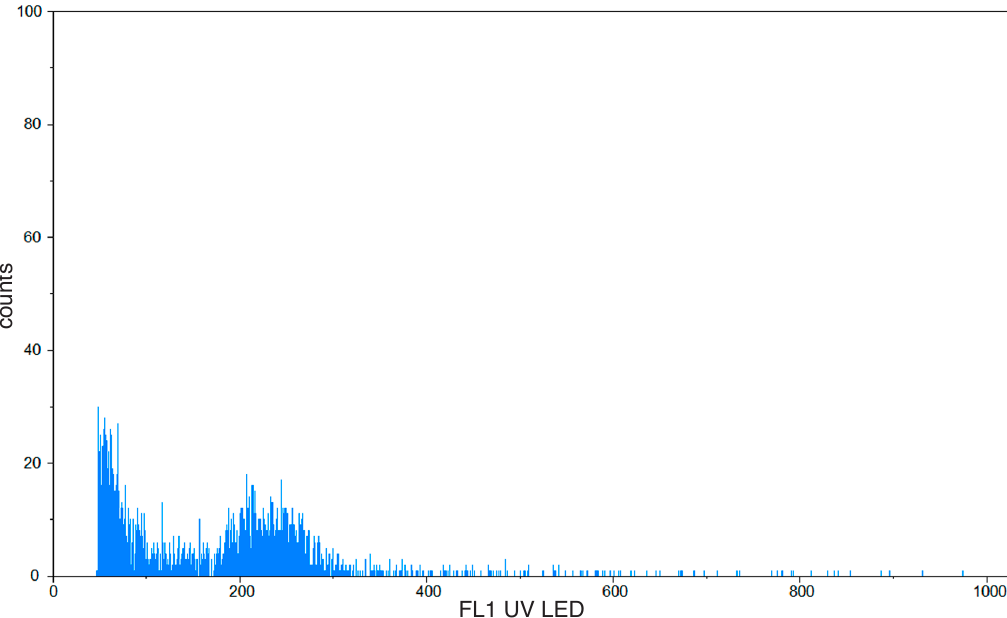
Fig. 2: Overlap of G1 peaks in tetraploid O. elata and internal standard (safflower)